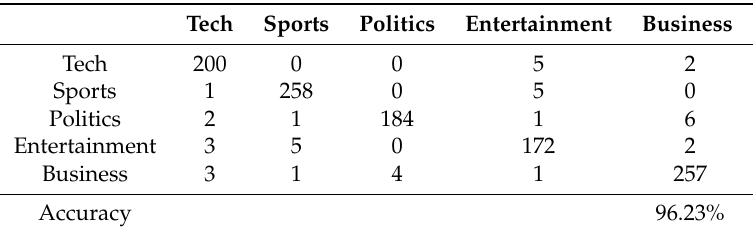
Table 5. Output of the BLSTM-C on the Chinese